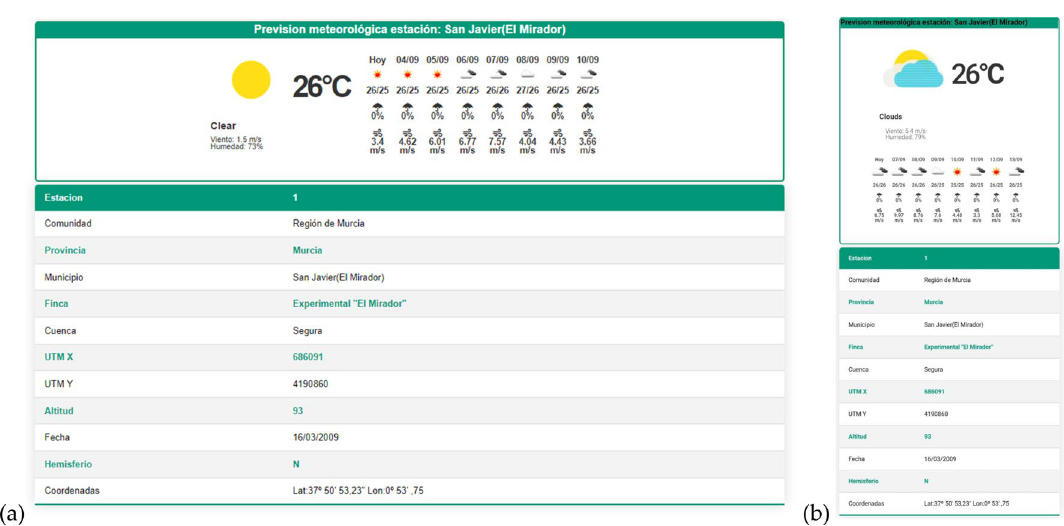
Figure 7. View of the weather forecast and data from the selected station in the ( a ) web application and ( b ) the mobile